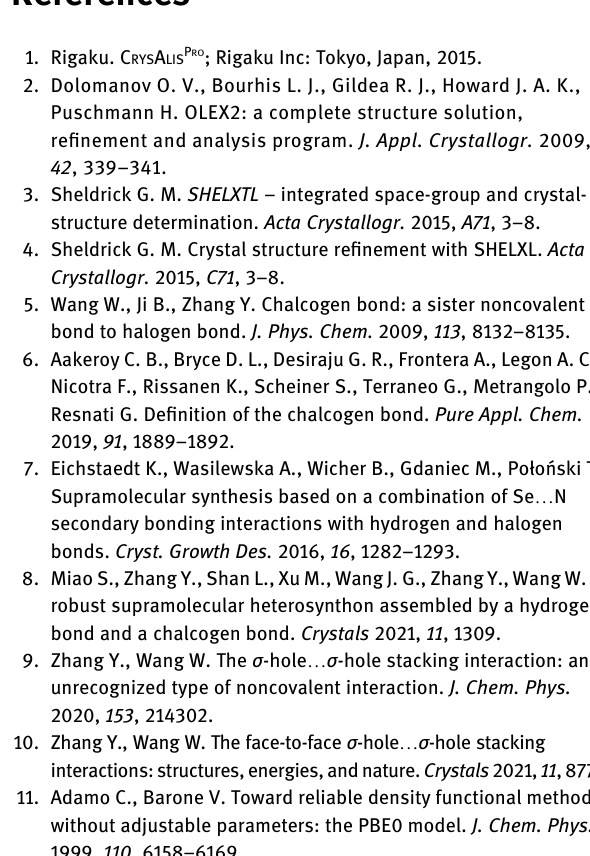
All bond lengths and angles in the title crystal structure are in the normal ranges. The 4,7-dibromo-2,1,3-benzo- selenadiazole molecules form 2D corrugated sheets which further self-assemble into a 3D layered structure. There are five typesof non-covalentinteractionsin the crystalstructure: